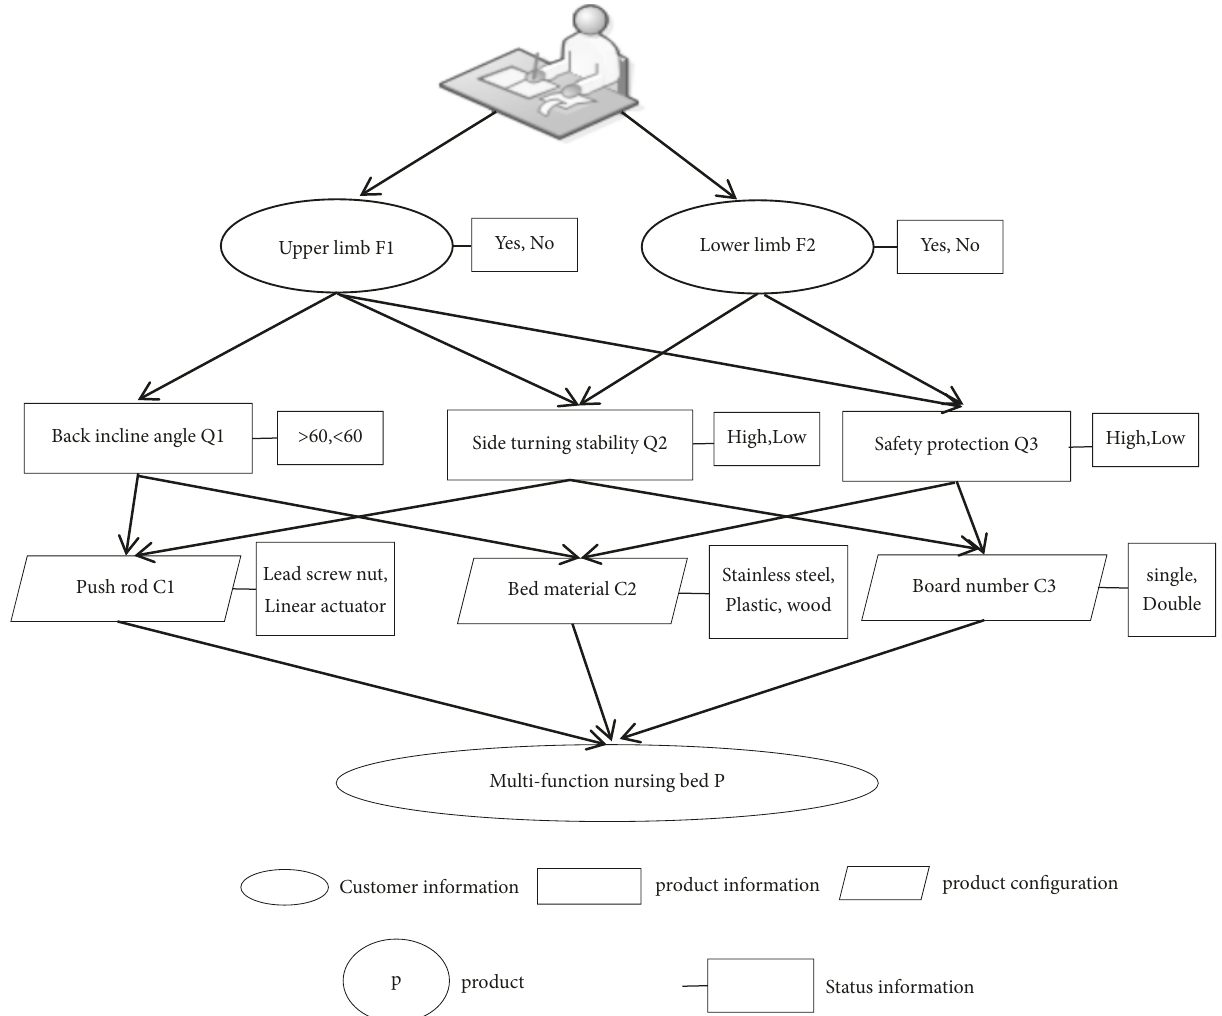
Figure 8: BN structure of multifunctional nursing